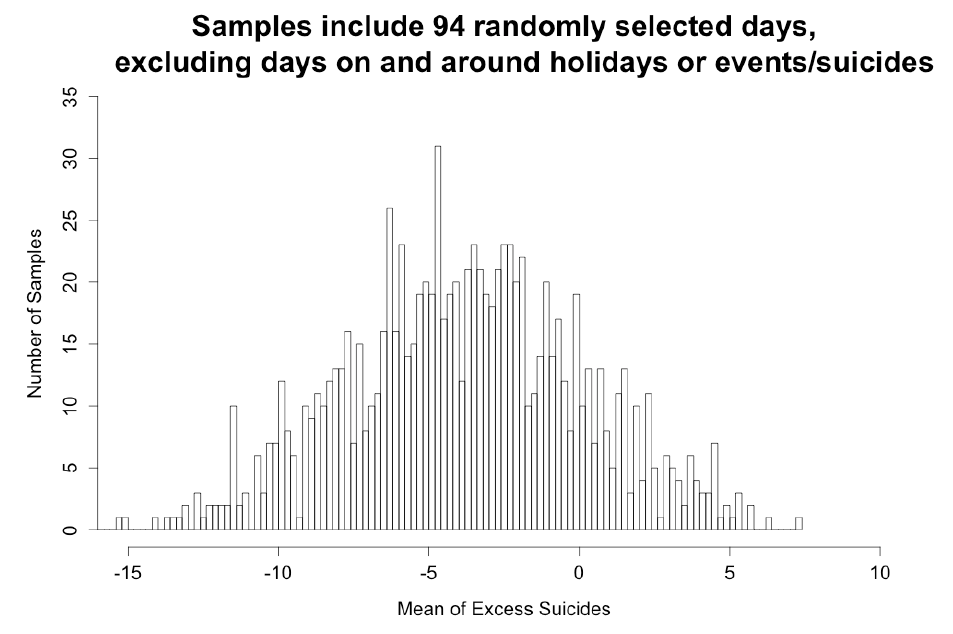
Figure 4: Robustness of effects for 1000 random samples of non-event or suicide